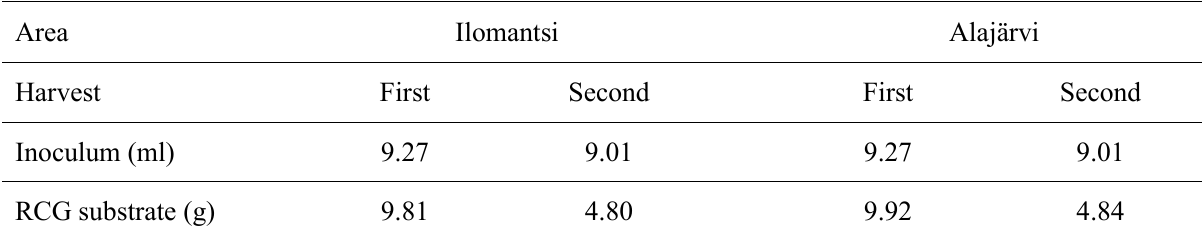
Table 3. Actual values (nominal 1:1 and 2:1 by VS content mL g -1 ) in incubation